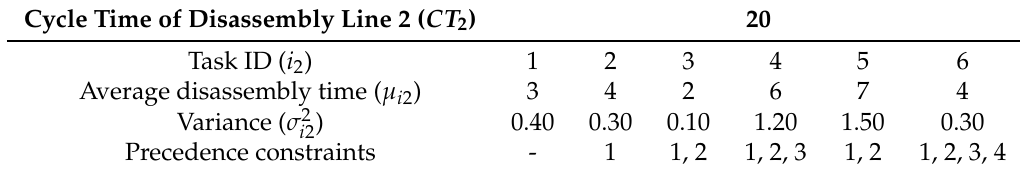
Table 3. The information of product B on disassembly line